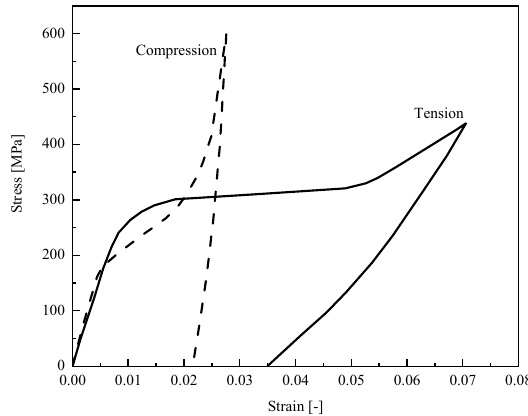
Figure 1. Experimental tension and compression responses for SMA beam at low temperature [36].